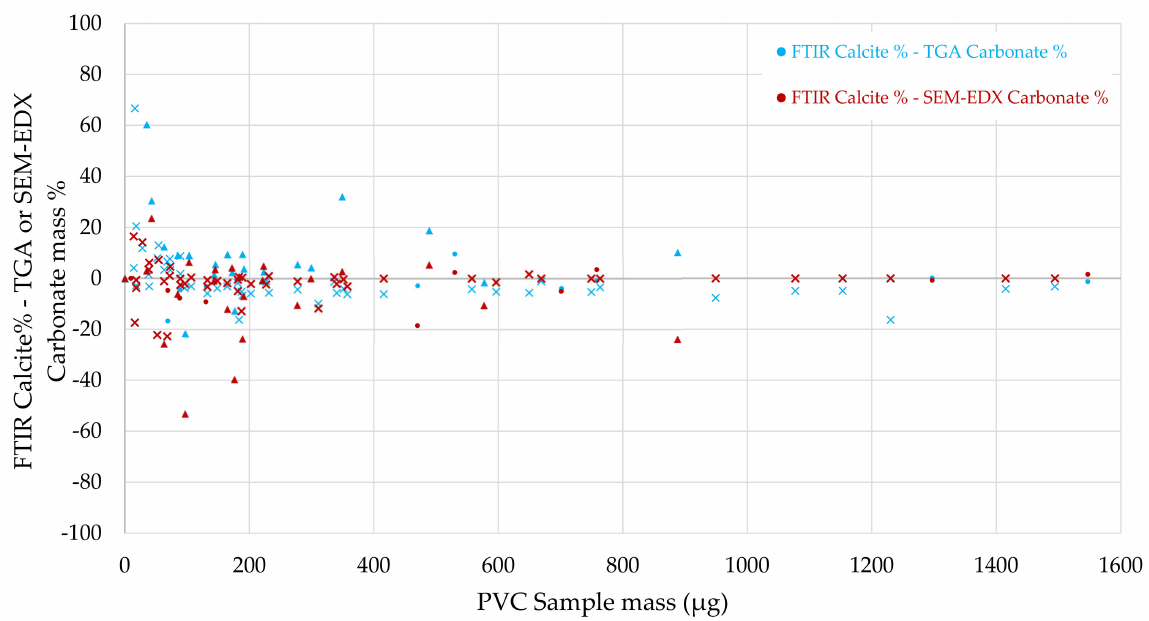
Figure 4. Difference between FTIR-based calcite mass % and TGA- or SEM-EDX-based carbonate mineral mass % versus sample mass on each PVC replicate sample collected in US underground coal mines ( n = 85 for both). × = FTIR calcite mass below LOD, (cid:78) = between LOD and LOQ; • = above